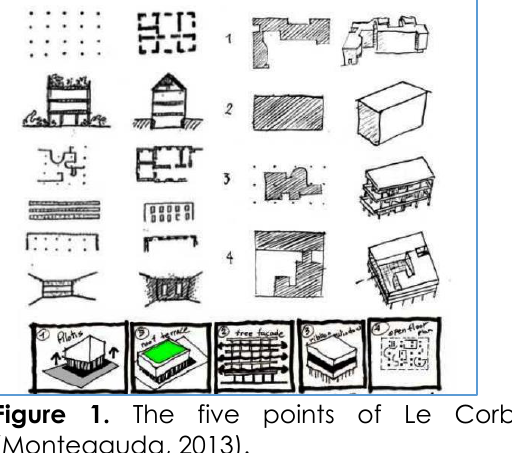
Figure 1. The five points of Le Corbusier (Monteaguda, 2013).